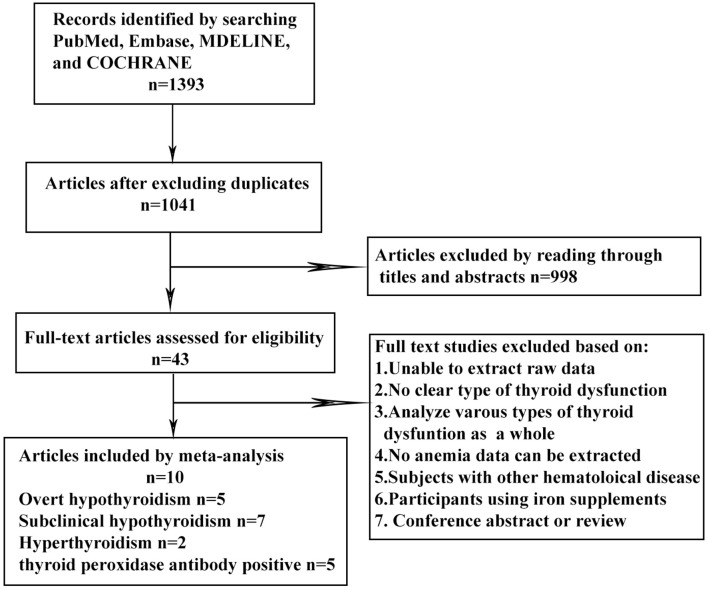
Flow chart of literature search and article selection.